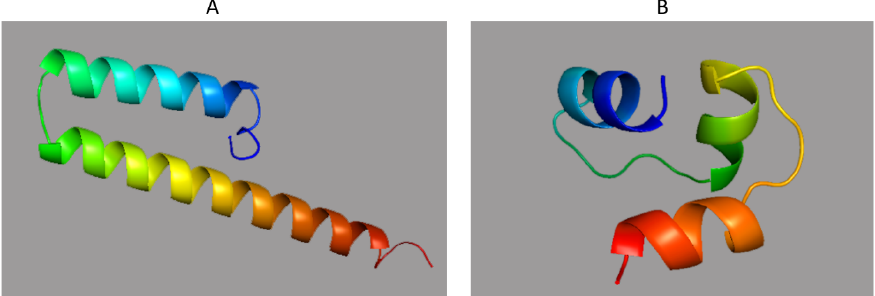
Figure 3. Structural models for NS5 of BTV ( A ) and AHSV ( B ). BTV NS5’s secondary structure is mainly predicted to be helical, while that of AHSV NS5 is typical of the winged tri-helical bundle structure of proteins that interact with Z-forms of nucleic